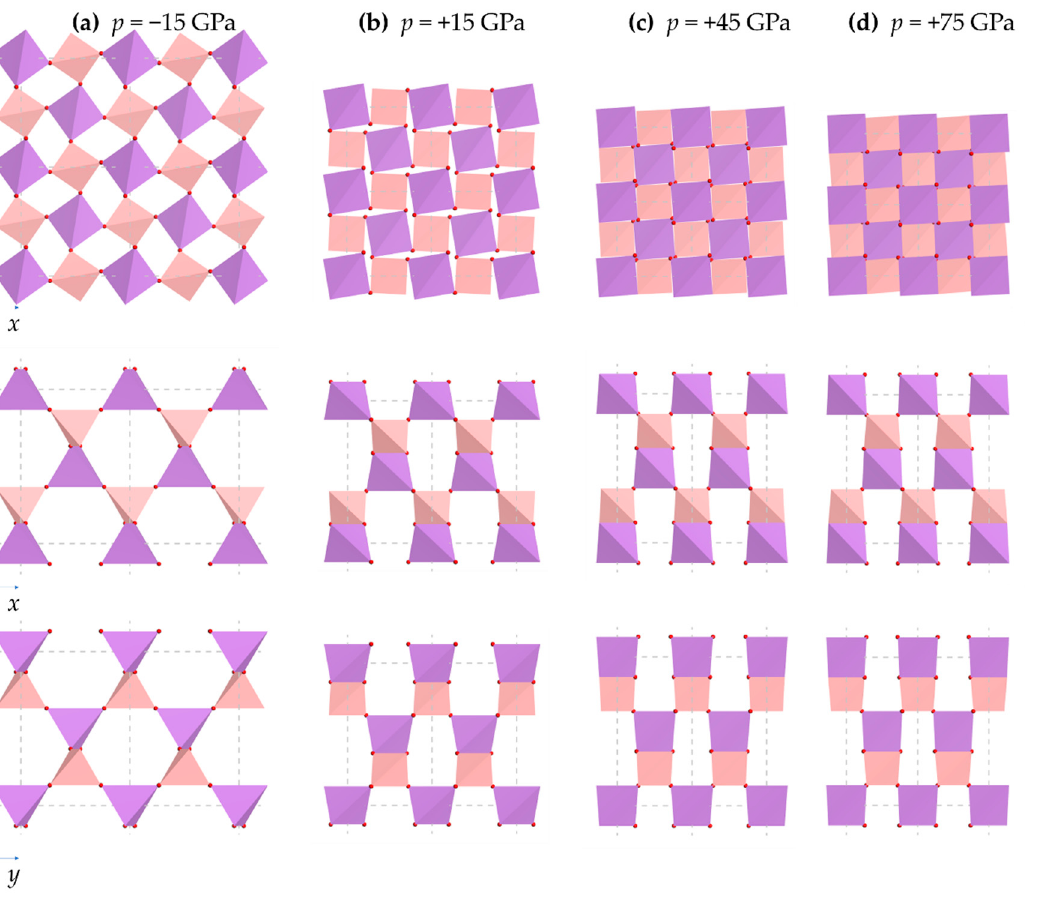
Figure 5. Images of the systems at various extents of applied pressure ( a ) − 15 GPa, ( b ) +15 GPa, ( c ) +45 GPa, and ( d ) +75 GPa, with changes in the crystal structure being very evident. These changes are also very evident by the differences in reflections/peak positions in the PXRD patterns, see Appendix B.